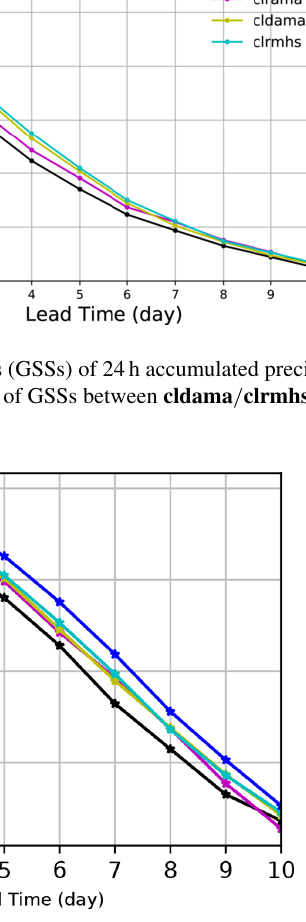
Figure 14. Global anomaly correlation coefficients of 500hPa geopotential height as a function of forecast lead time for the four cycling experiments together with the cold-start forecasts initialized from GFS analyses